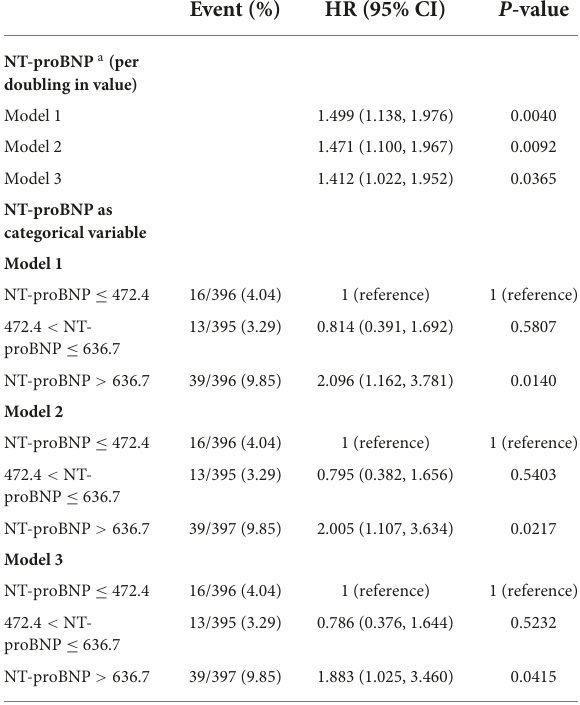
TABLE 3 The multivariable analysis of the association between NT-proBNP level and MACE